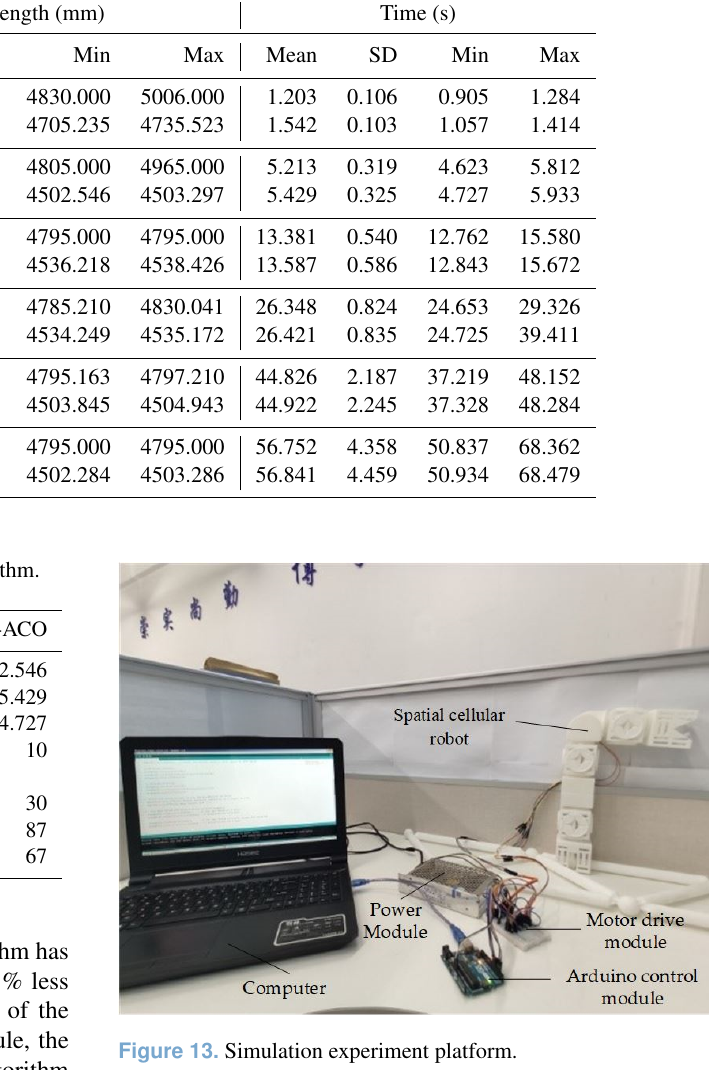
Table 3. Comparison of optimization results of two algorithms